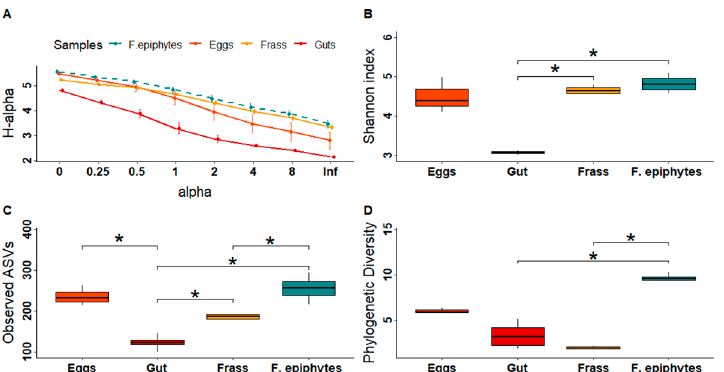
Figure 1. Distribution of alpha diversity in samples collected from the plant D. inoxia and its specialist insect L. daturaphila . ( A ) Comparison of the R è nyi profiles of bacterial communities considering the total number of ASVs. Alpha values of 0, 1, 2, and infinity correspond to the species richness, Shannon diversity index, the logarithm of the reciprocal Simpson diversity index and Berger–Parker diversity index, respectively. Each colour represents a different sample. Solid lines correspond to insect samples, while dotted lines correspond to plant samples. ( B ) Richness. ( C ) Index of Shannon. ( D ) Phylogenetic diversity. Endophyte and seed samples were not included in this analysis, given the relatively small number of ASVs identified. Asterisks denote significant differences following an ANOVA test ( P < 0.05).